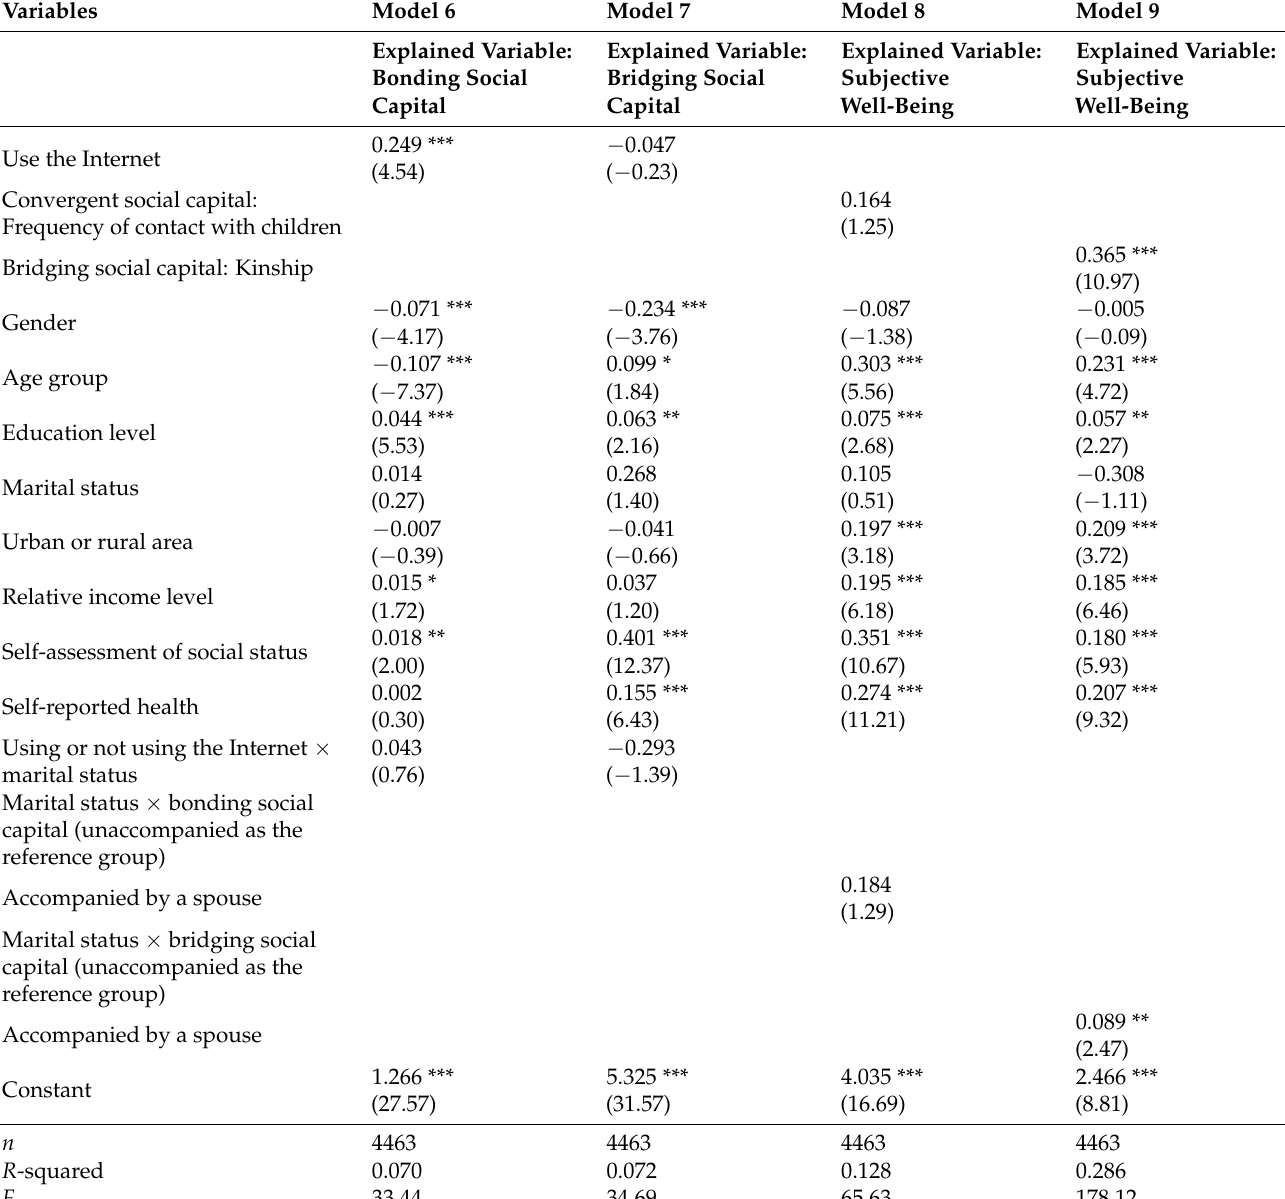
Table 5. The moderating effect of marital status on the influence path of the intermediary